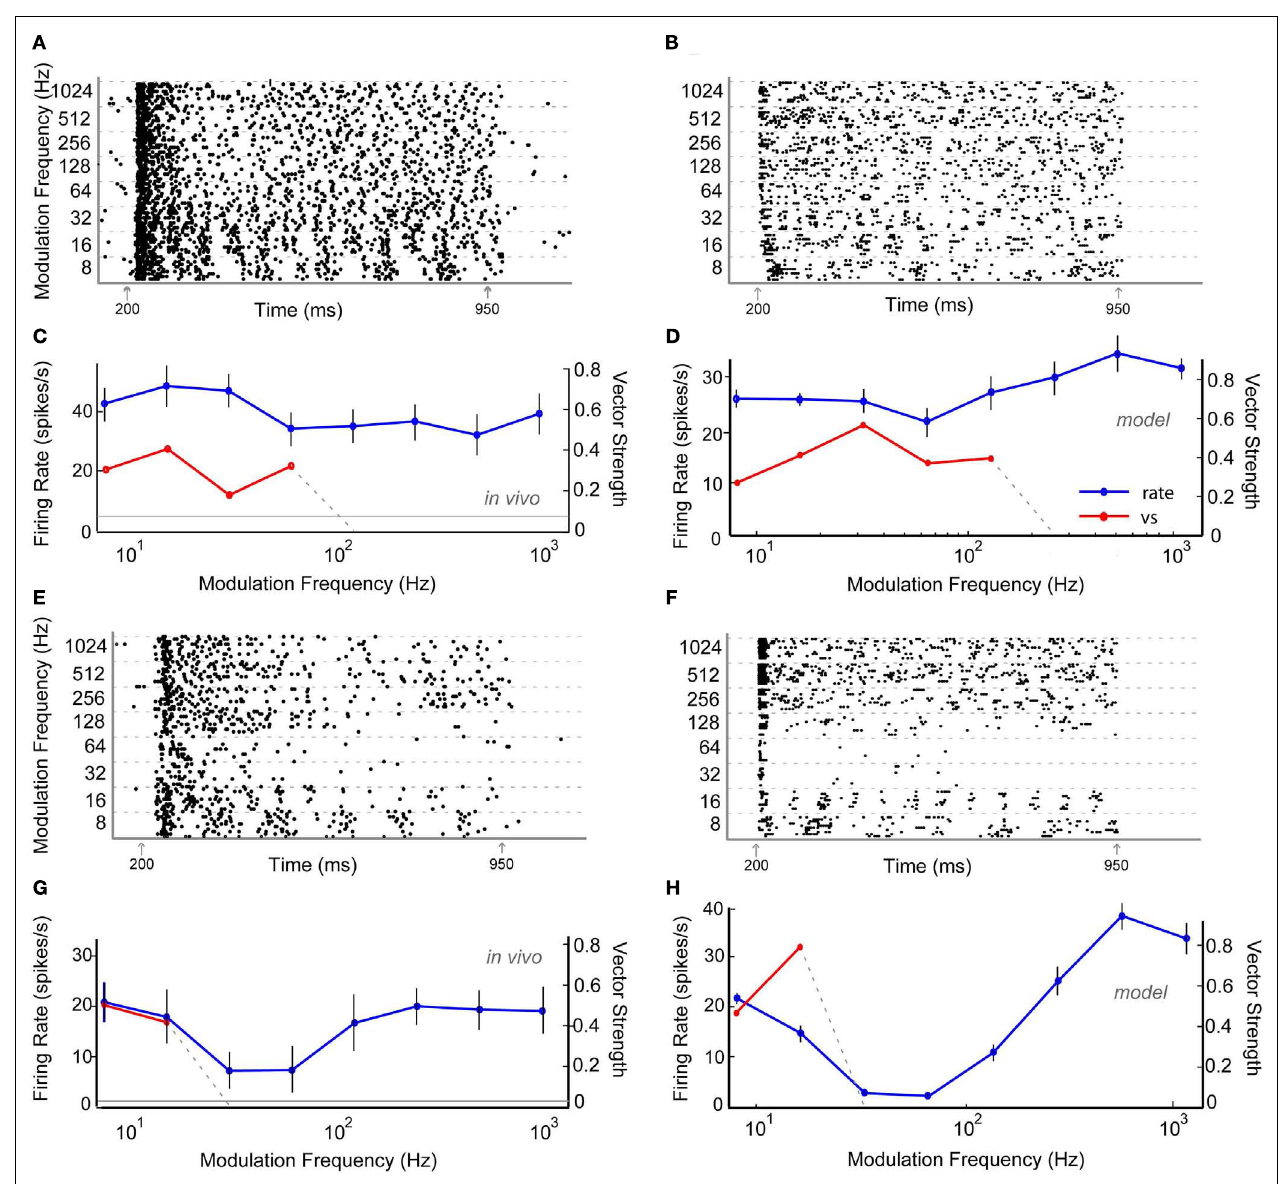
neuron described in (B) . (E) Dot-raster plot of responses of unitY22 from the IC of a young animal to nAM stimuli presented at 65dB SPL. (F) Dot-raster plot of responses from an Adapting model neuron with 2VCN and 6VNLL band-pass rate tuned inputs (rBMF = 36Hz). (G) Mean firing rate and vector strength of neuron shown in (E) for various modulation frequencies, exhibiting band-reject rMTF and low-pass tMTF. (H) Mean firing rate (blue) of 10 trials, and significant vector strength (red) of model neuron shown in (F) . All axes similar to Figure 4